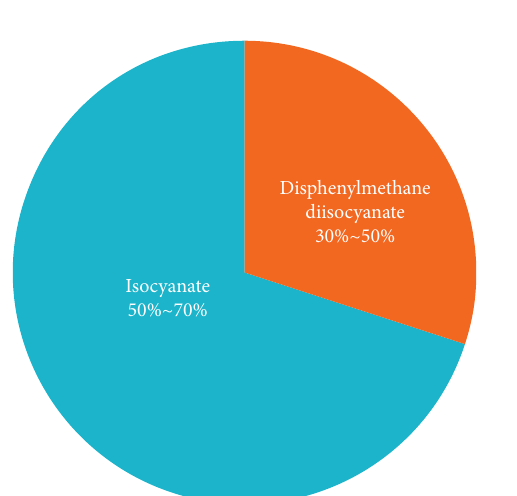
Figure 1: Schematic diagram of chemical reaction of urethane group.